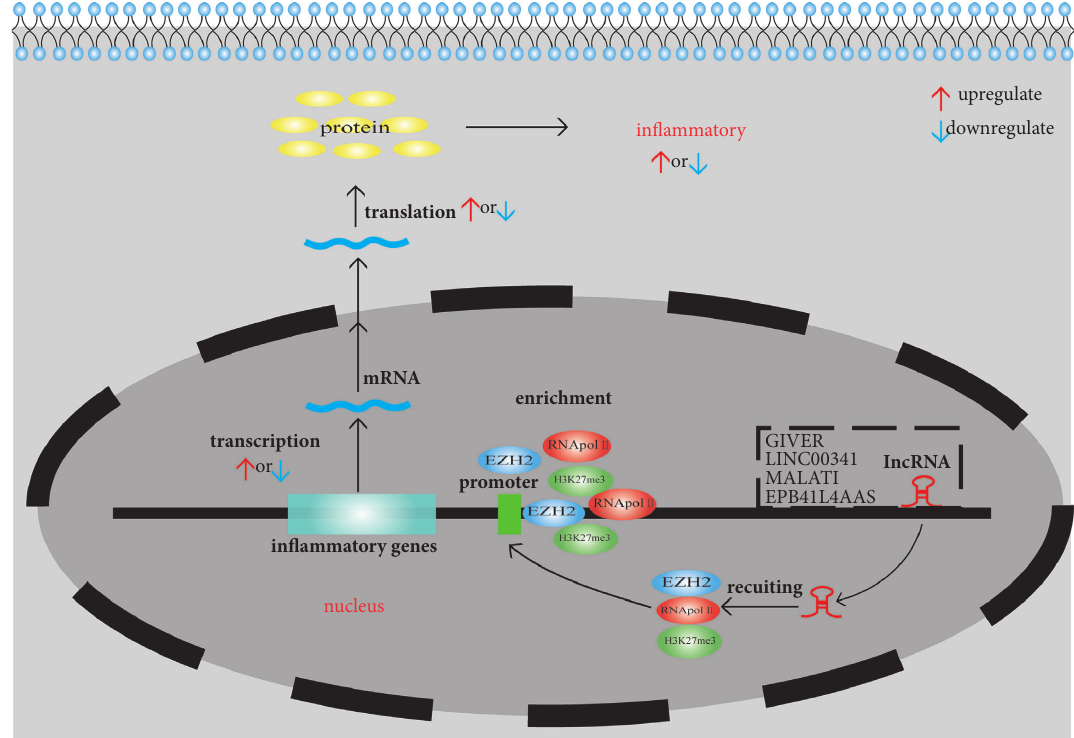
Figure 1: The role of lncRNA in epigenetics. DNA methylation by lncRNAs recruiting histone enzymes (EZH2, RNA polymerase II) leads to an increase or decrease in gene expression, which eventually leads to the upregulation or downregulation of